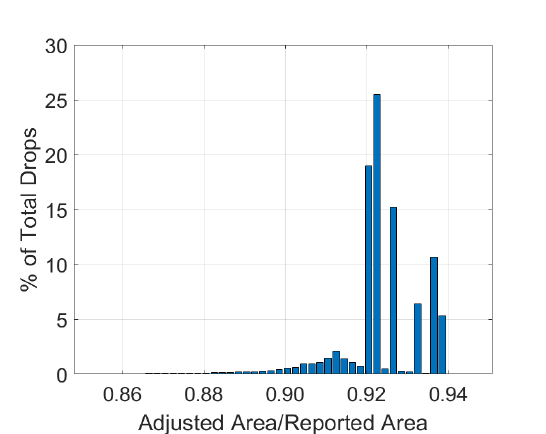
Figure 11. A histogram showing the ratio between the adjusted area and the manufacturer-reported area for all of the non-spurious drops retained in the ensemble. Note that all adjusted areas are at least 6% smaller than the manufacturer-reported areas in the output file of the